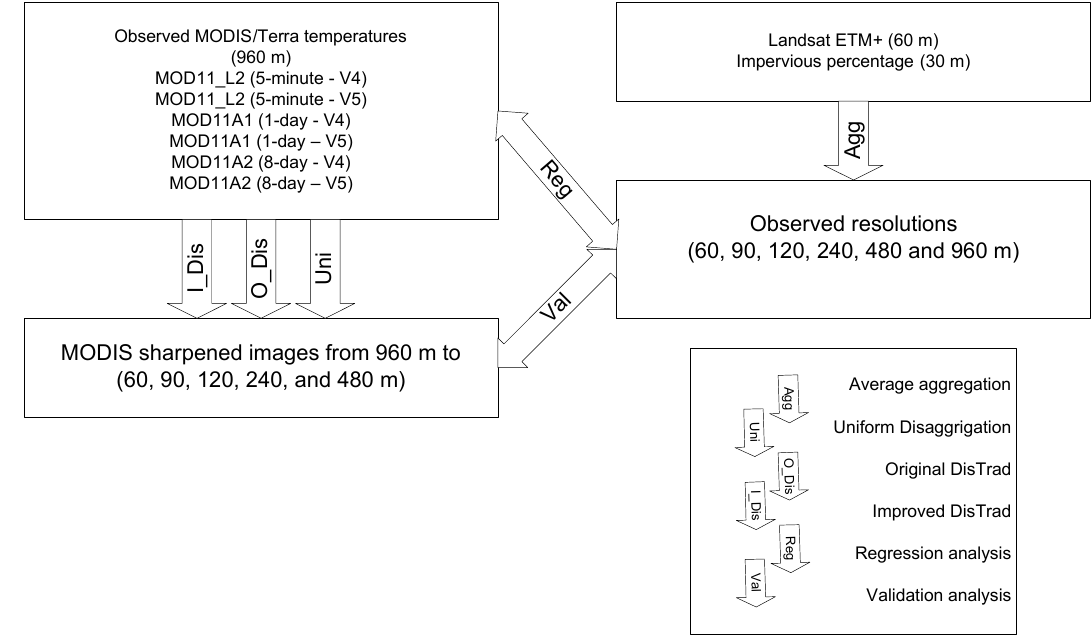
Figure 6. Schematic diagram presenting an overview of the aggregation, re-sampling, downscaling, regression analysis, and validation, at different resolutions (60, 90, 120, 240, 480 and 960 m).